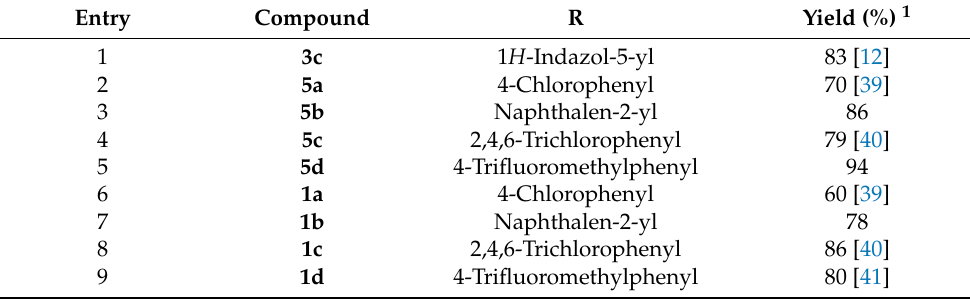
Table 2. Experimental data of compounds 1a – d , 3c , and 5a – d .